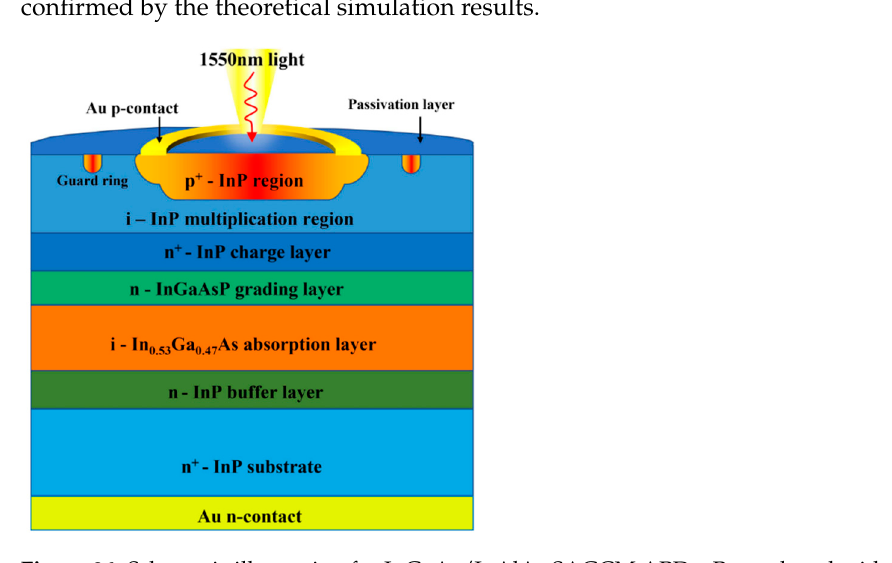
Figure 37. I-V and gain characteristics of the InGaAs/InP SAGCM structure. Reproduced with per- mission from [91], IEEE, 2022. B. F. Levine et al. [92] reported a novel backside-illuminated InGaAs/InAlAs APD with a planar buried multiplication region, which is shown in Figure 38. Compared with other standard APDs, this structure has several advantages: (I) both InAlAs multiplication region and the InAlAs charge region were in-situ doped in the growth chamber, (II) the fabrication process was greatly simplified, (III) there was good wafer uniformity and high reproducibility, etc. Experimental result shows that GBP for this structure is as high as 150 GHz.